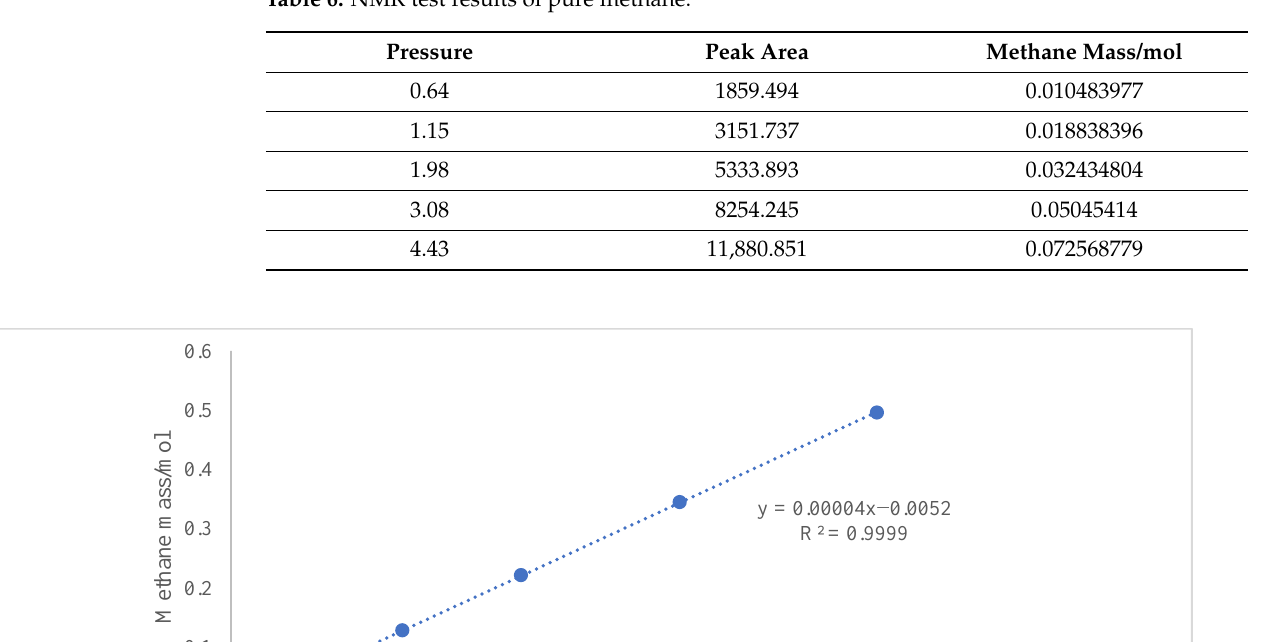
Table 6. NMR test results of pure methane.